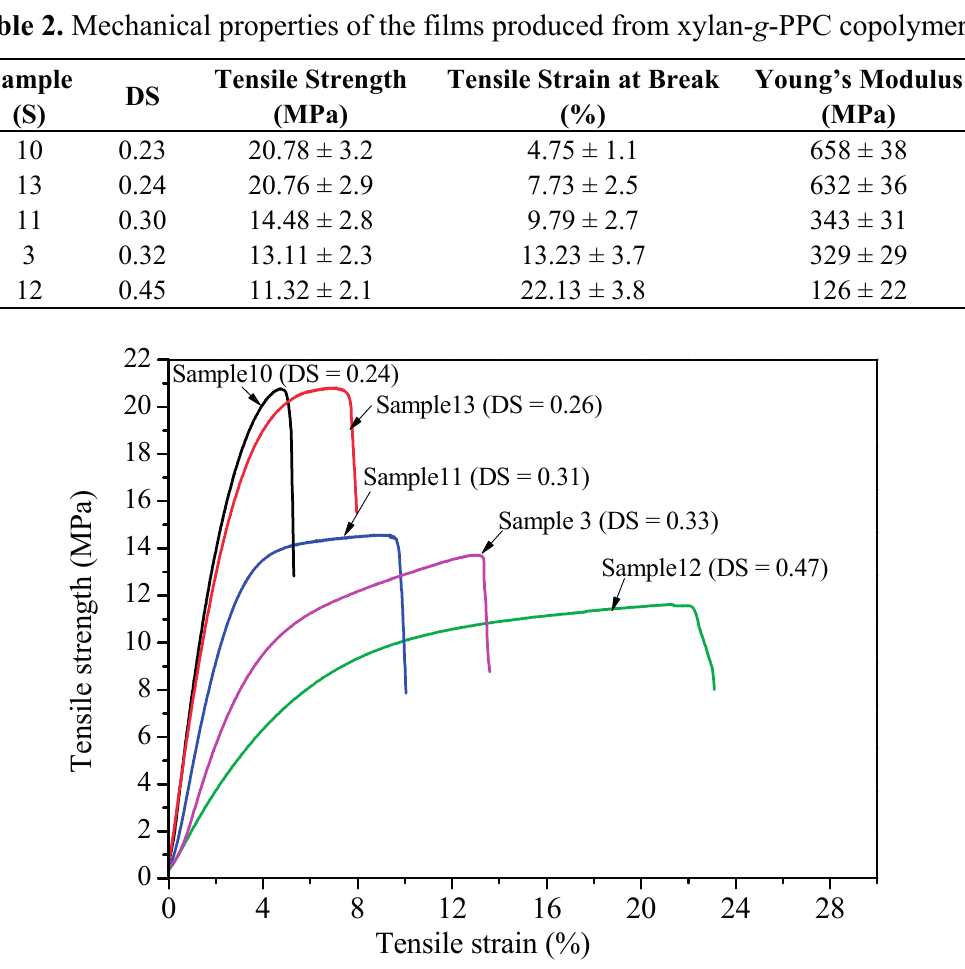
Figure 6. Tensile strain curves of xylan- g -PPC copolymers